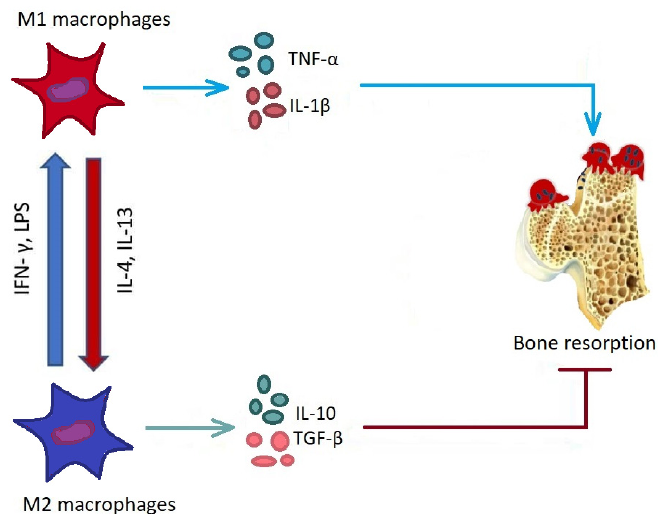
Figure 2. Effect of macrophages on bone resorption. M1-like macrophages can secrete TNF- α and IL-1 β , inducing bone resorption. M1-like macrophages can differentiate into osteoclasts and partic- ipate in the formation of bone erosions. M2-like macrophages can secrete IL-10 and transforming growth factor-beta (TGF- β ), inhibiting bone